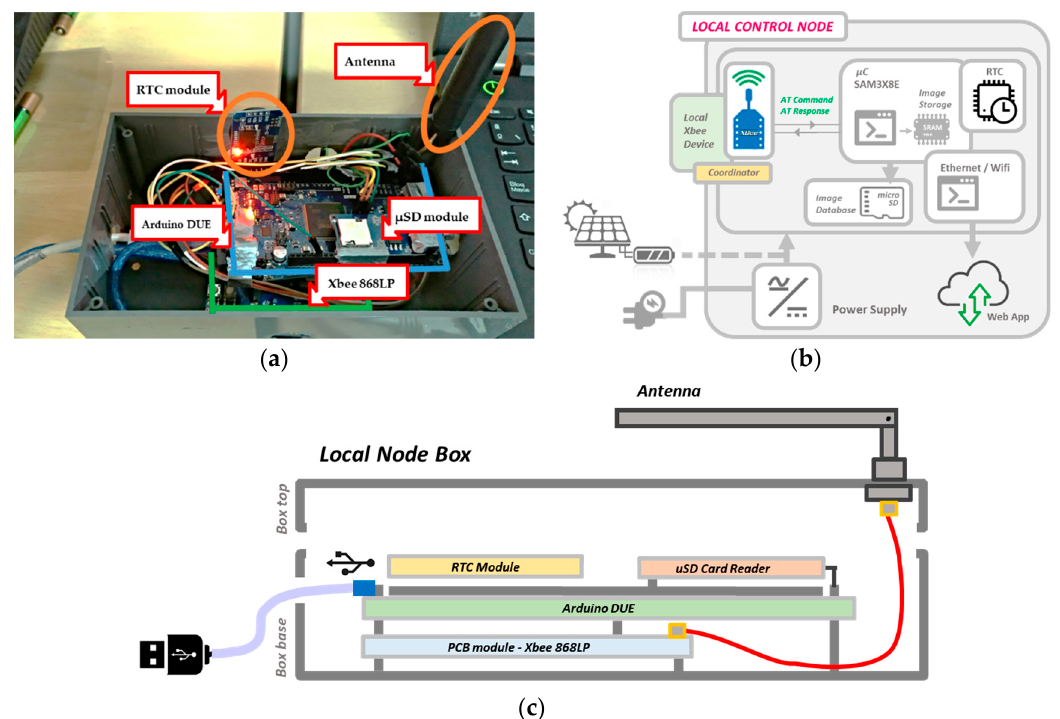
Figure 6. Sample view and diagram of the coordinator node. ( a ) Final prototype assembly of the node. ( b ) Schematic diagram of the node. ( c ) Diagram of the elements in a stacked mount; the elements are placed in a stacked mount to save space and increase the capabilities of the prototype.